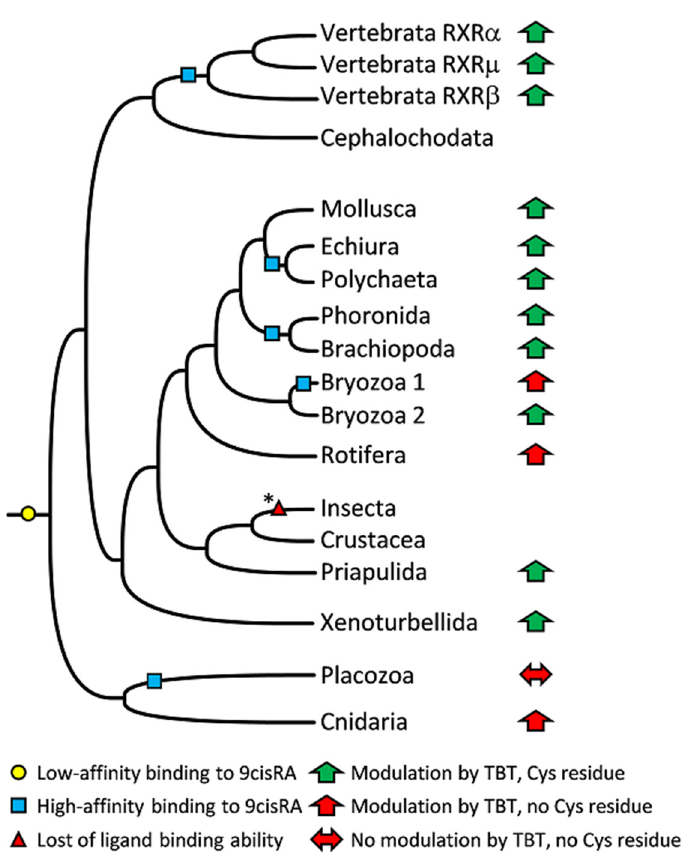
Figure 6. Evolutionary conservation of RXR modulation by 9cisRA and tributyltin. * The ultraspiracle (USP) ortholog from the earlier branching orthopteran Locusta migratoria retains high affinity towards 9cisRA and all-trans retinoic acid.